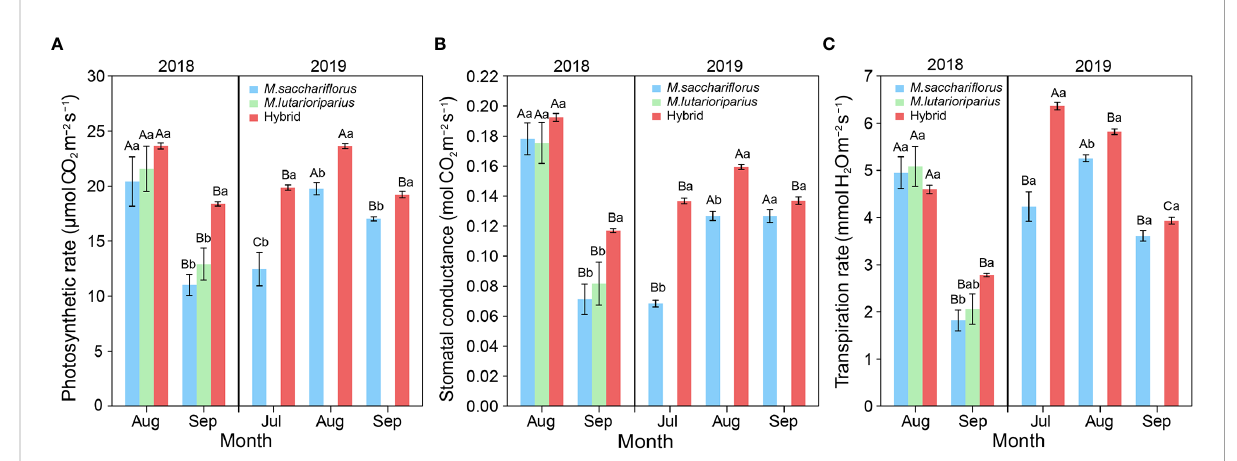
FIGURE 3 Differences of (A) average photosynthetic rate, (B) the advantage in average stomatal conductance, (C) transpiration rate between measuring hybrid and female parent individuals in both 2018 and 2019 growing season, and male parent individuals in 2018. Different capital letters A, B and C represent a signi fi cant difference of photosynthetic rate, stomatal conductance, and transpiration rate between growth months at P <0.05 level, respectively. Different lowercases a and b represent a signi fi cant difference of photosynthetic rate, and stomatal conductance, and transpiration rate between M. sacchari fl orus , M. lutarioriparius and their hybrids at P <0.05 level, respectively. Error bars indicate standard error of 333 surviving hybrid individuals, 5 and 3 surviving female parent individuals in both 2018 and 2019, and 10 surviving male parent individuals in 2018,